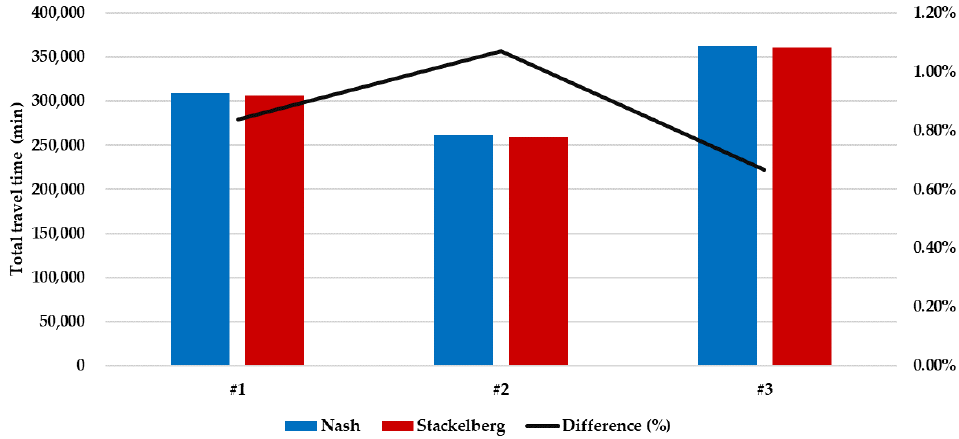
Figure 11. Compared total travel times of the entire traffic flow for the three scenarios. (The difference Figure 11. This is a figure. Schemes follow the same formatting. If there are multiple panels, they (%) represents the percentage increase in total travel time between the results of the Stackelberg should be listed as: ( a ) Description of what is contained in the first panel. ( b ) Description of what is approach and the Nash equilibrium for each contained in the second panel. Figures should be placed in the main text near to the first time they are cited. A caption on a single line should be centered.